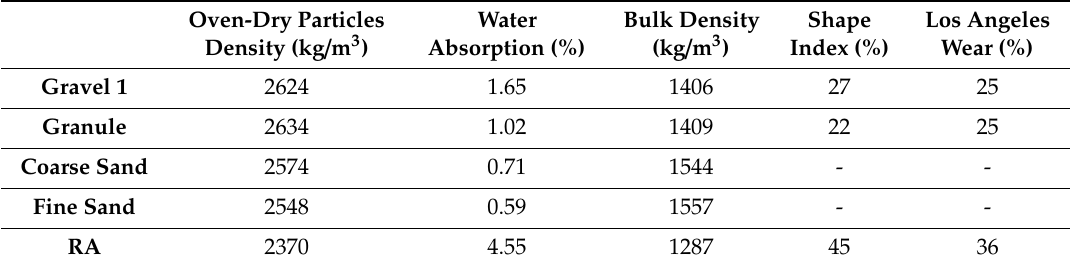
Table 2. Physical properties of the aggregates.